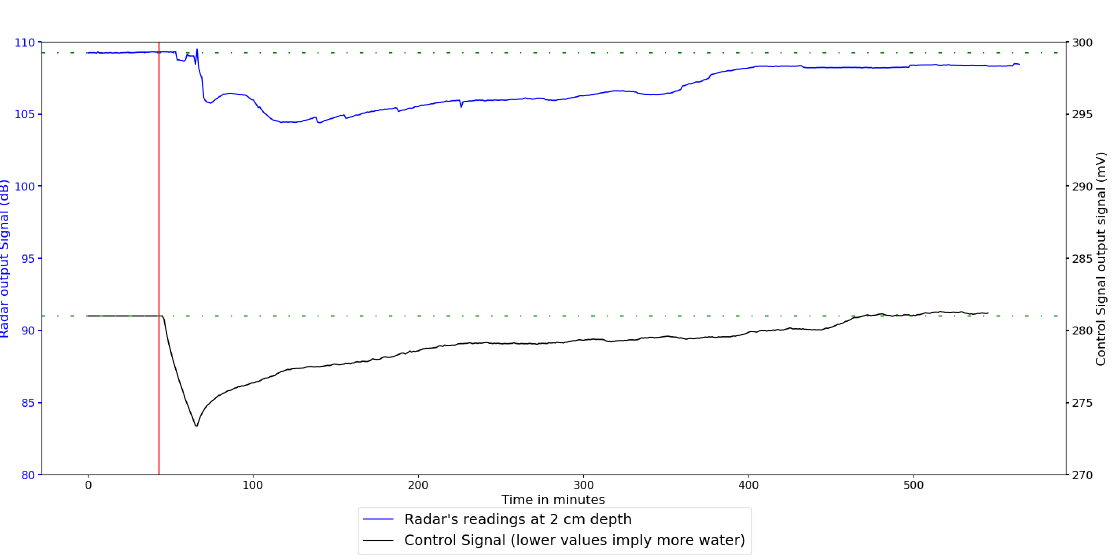
Figure 5. RADAR’s readings vs. control signal at 2 cm depth. The vertical red solid line represents the moment when the water was added.